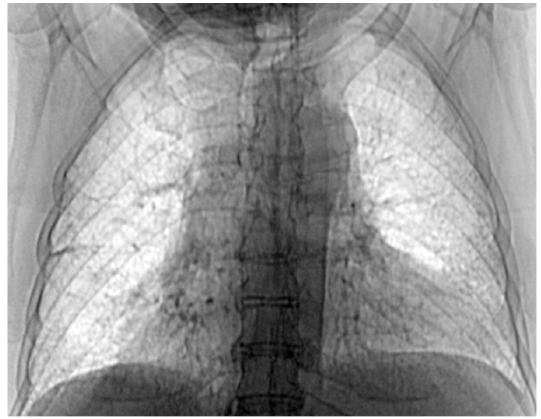
Figure 18. The image from Figure 17 in “Invert color” format. Figures 19 and 20 present the defined masks for left lung and right lung, framed in blue borders.